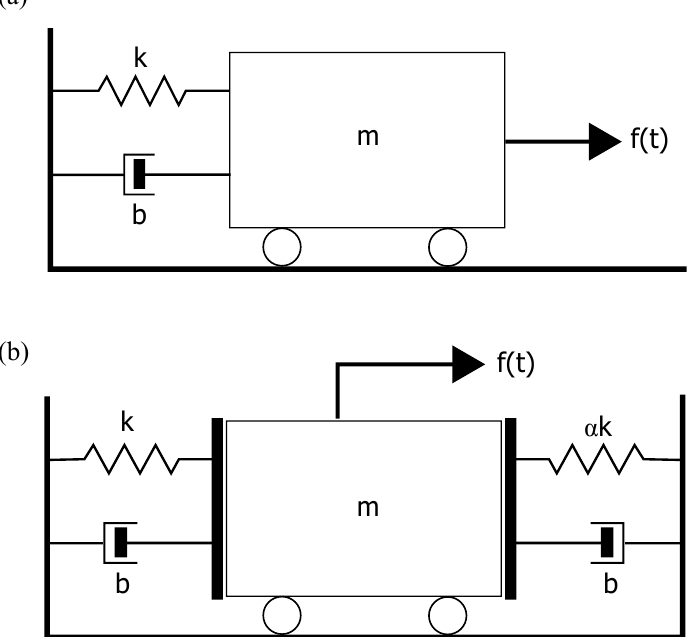
Figure 2. Schematic of simulated oscillator scenarios. ( a ) Linear and ( b ) bilinear 1-DoF systems were excited by a Gaussian white noise. Damage was introduced in the linear case by changing the stiffness k to 0.5 k. For the bilinear case, damage was introduced by changing α from 1 to 0.5. The experimental dataset was produced by the experimental setup shown in Figure